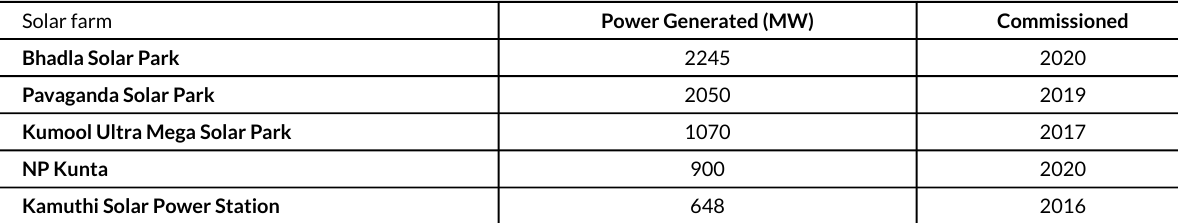
Table 4. The largest five solar farms in India